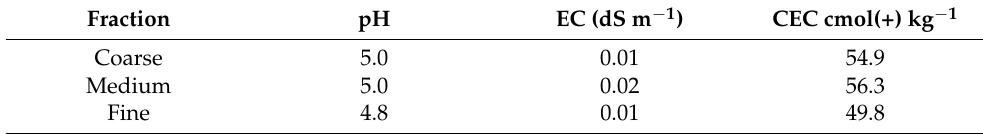
Table 1. Characterization of the fractions of raw soil.